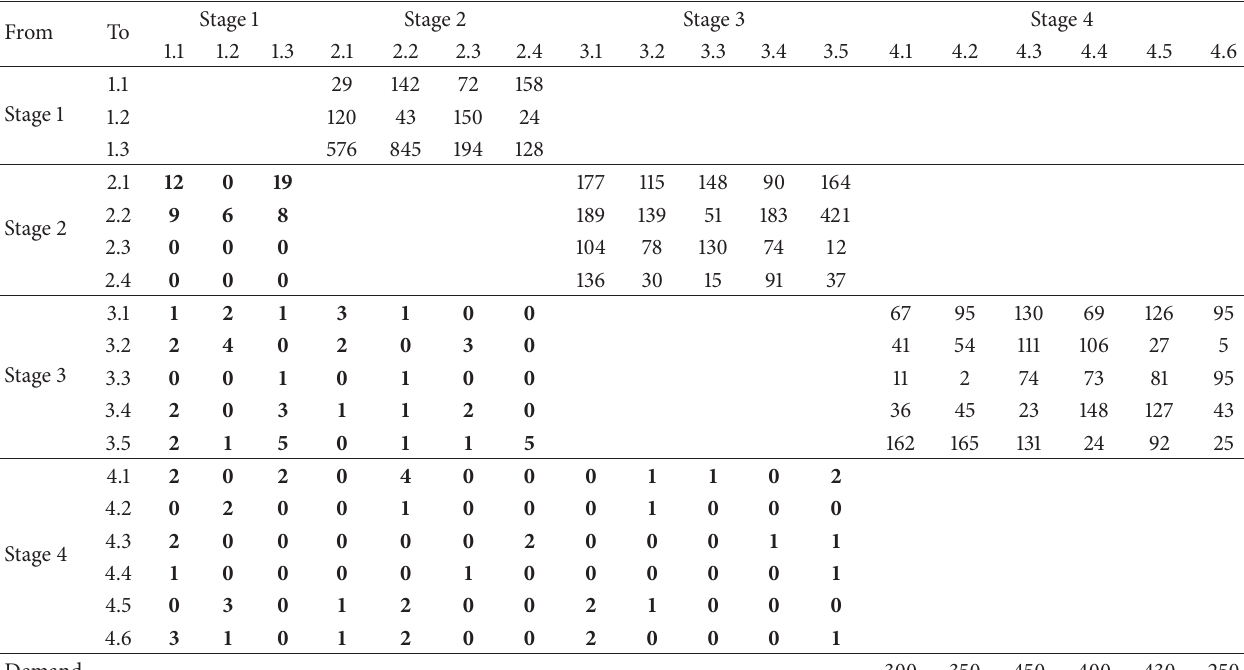
Table 14: The second period transportation plan by PSOA